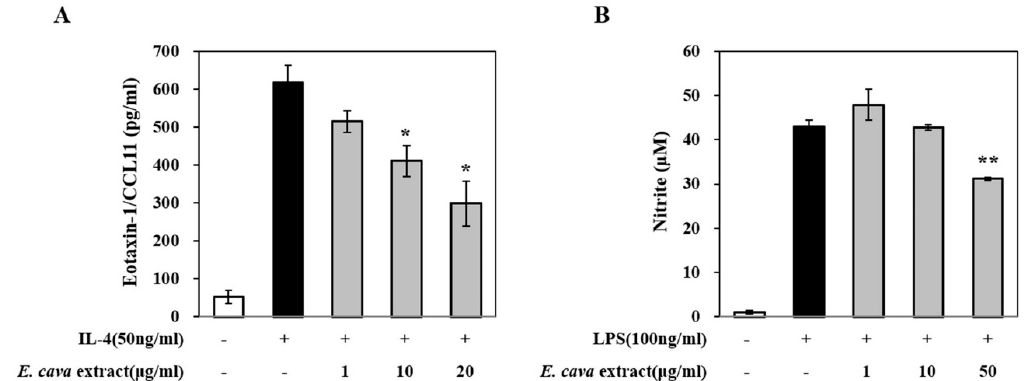
Figure A1. Effect of E. cava extract on inflammation factors expression induced by pollution stress. NIH / 3T3 cells were pretreated with E. cava extract, then further incubated with IL-4 (50 ng / mL). Culture cell medium was collected, and the release of eotaxin-1 / CCL11 was measured by ELISA ( A ). RAW264.7 cells were pretreated with E. cava extract, and then stimulated with lipopolysaccharide (LPS, 100 ng / mL). Culture cell medium was collected, and the release of NO was measured by Griess assay ( B ). Each graph means average value of each data and standard variation was shown as error range. The experiment was conducted in